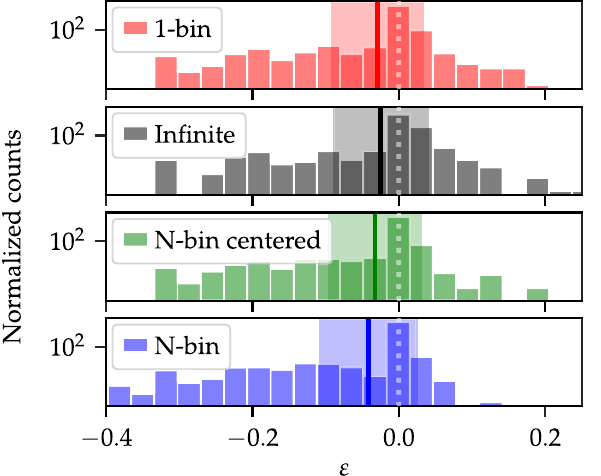
Fig. 11 Distributions of ε for the four strategies considered. The width of the colored vertical line, centered at the mean, corresponds to the standard deviation of the mean, and the light shaded area is the standard deviation. A vertical white dashed line marks null bias. We exclude events that do not pass the distance cut r > r min (see text for details). Each count is one reconstructed trace, which was gener- ated from sampling r from the realistic distribution (c.f. Fig. 6), and taking as input the average muon profile of proton showers in an hexag- onal array with 17 . 6 ≤ log 10 ( E / eV ) ≤ 17 . 8 and 27 ◦ (cid:2) θ (cid:2) 33 ◦ (0 . 20 ≤ sin 2 θ ≤ 0 . 30)